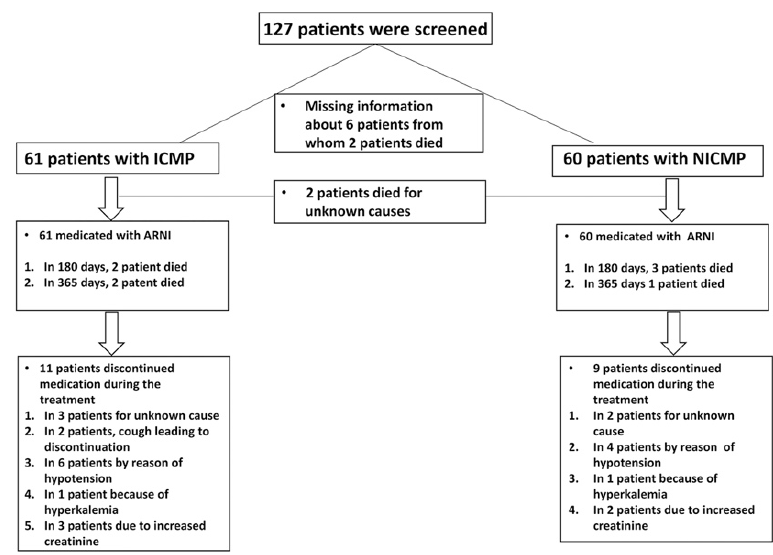
Figure 1. Study design.